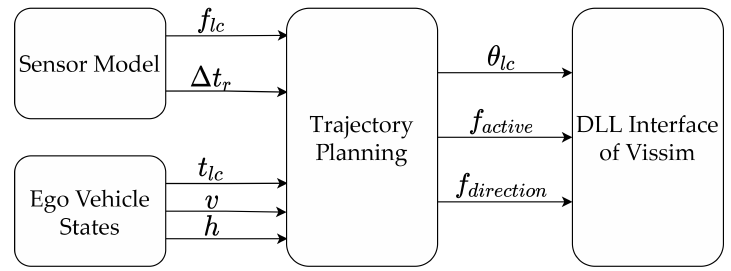
Figure 5. Lateral control schema in the driving